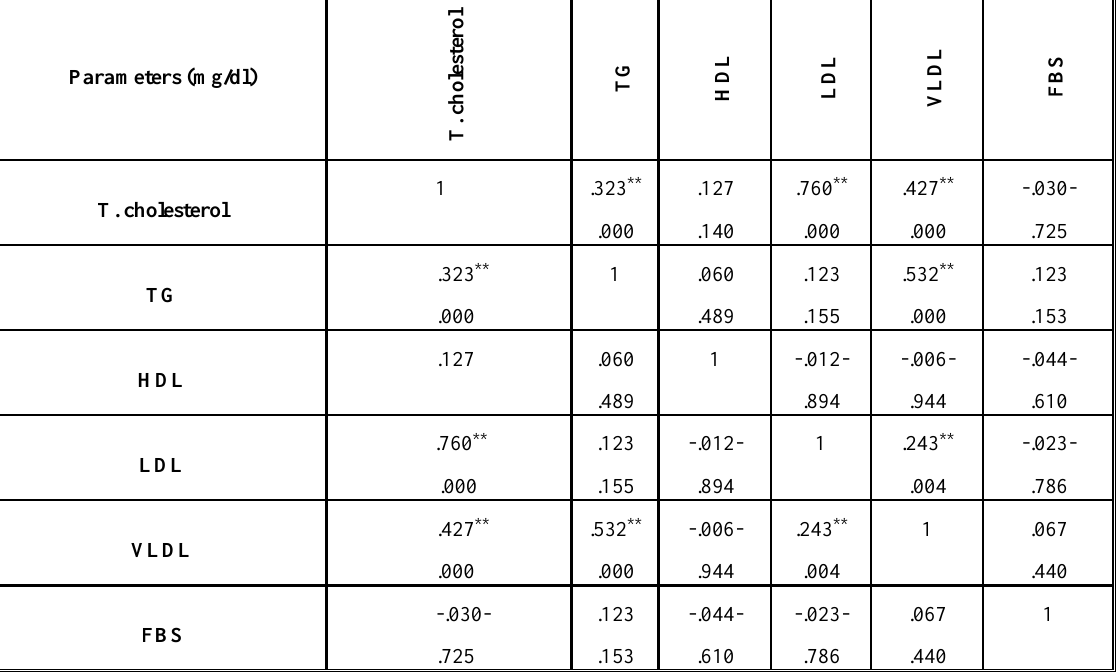
Table (2): Pearson rank correlations between